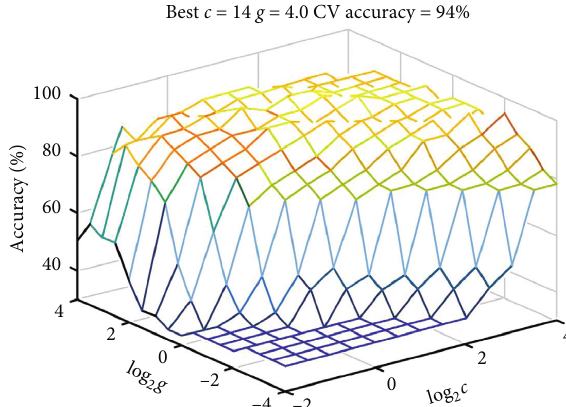
Figure 14: 3D view of parameter